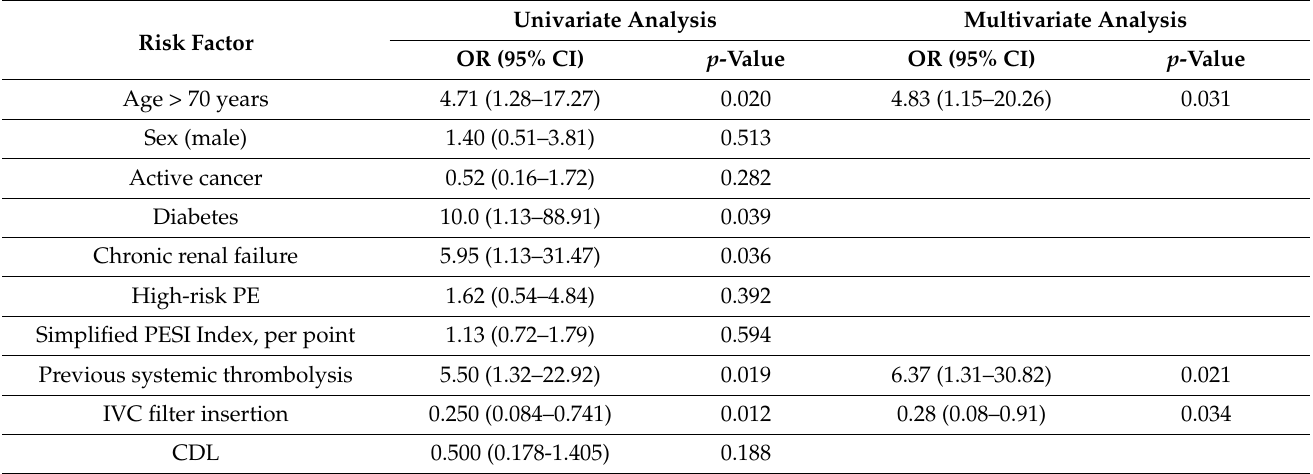
Table 5. Factors associated with in-hospital all-cause